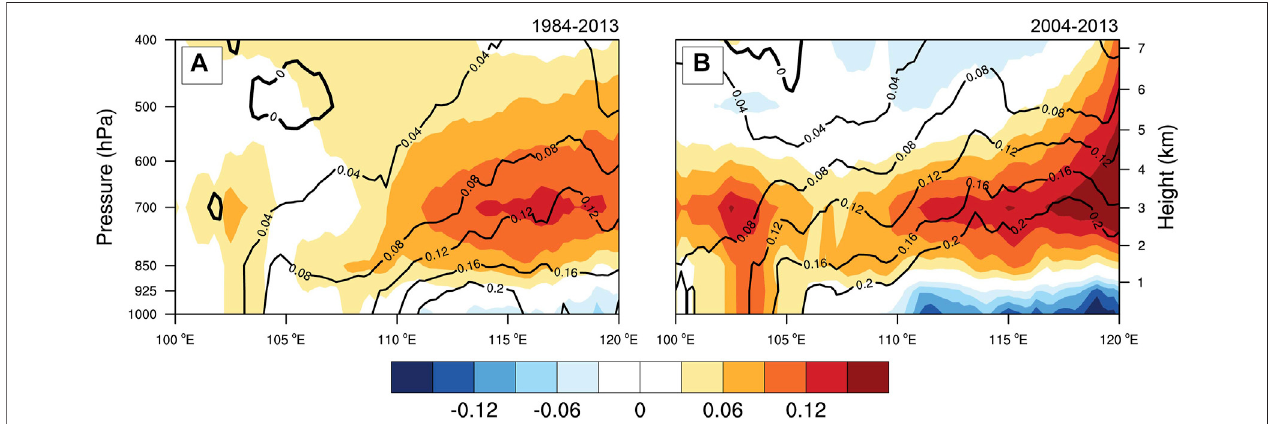
FIGURE 8 | The meridional sections (longitude-height) of the LUCC-induced changes in equivalent potential temperature ( fi lled color; units: K) and atmospheric speci fi c humidity (contours; units: g/kg) for the southern China (averaged over 21.5 – 30 ° N) in the POF season during (A) 1984 – 2013 and (B) 2004 – 2013.